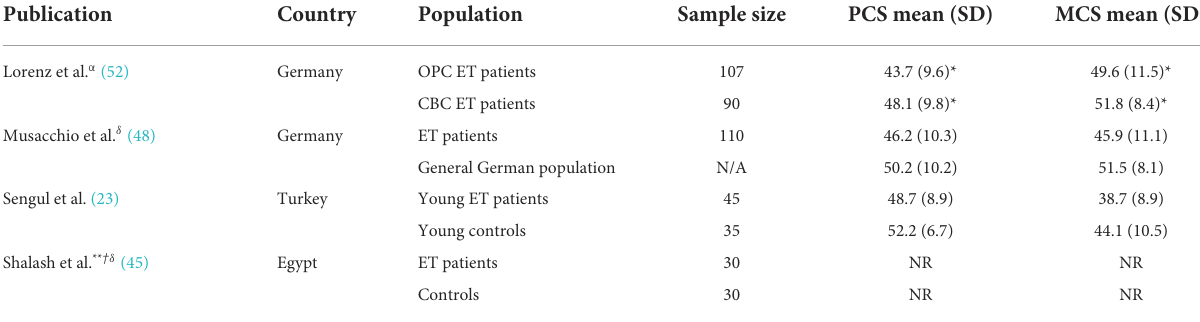
TABLE 5 Mean scores for the 36-item short form